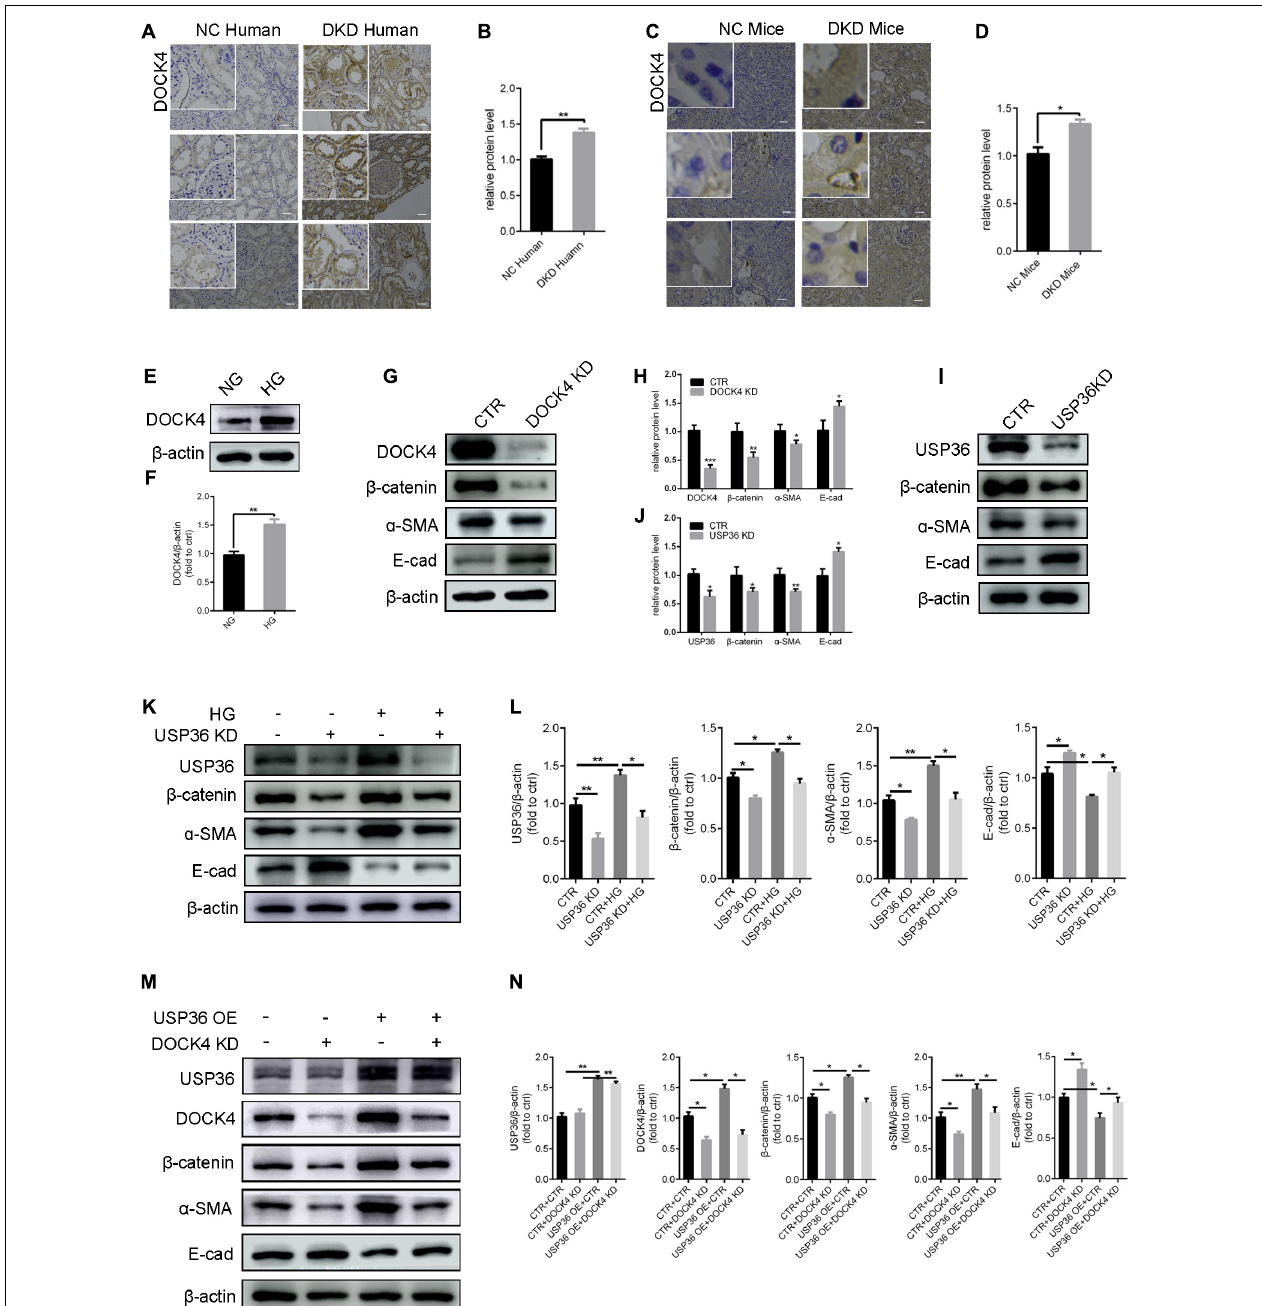
FIGURE 5 | USP36 regulates EMT induced by high glucose of TECs via DOCK4-dependent Wnt/ β -catenin signaling pathway. (A,B) Immunohistochemistry staining for DOCK4 expression in human kidney sections. Scale bars = 100 µ m, n = 3. (C,D) Immunohistochemistry staining for USP36 expression in mouse renal tissues. Scale bars = 100 µ m, n = 3. (E,F) WB analysis of the protein levels of DOCK4 in high glucose induced TECs. Data are presented as the mean ± S.D, n = 3, * p < 0.05. (G,H) WB analysis of the protein levels of DOCK4, β -catenin, α -SMA and E-cad in TECs after knockdown of DOCK4. Data are presented as the mean ± S.D, n = 3. * p < 0.05, ** p < 0.01, and *** p < 0.001. (I,J) WB analysis of the protein levels of USP36, β -catenin, α -SMA and E-cad in TECs after knockdown of USP36. Data are presented as the mean ± S.D, n = 3, * p < 0.05, and ** p < 0.01. (K,L) WB analysis of the protein levels of USP36, β -catenin, α -SMA and E-cad in TECs exposed to long time high glucose following the knockdown of USP36. Data are presented as the mean ± S.D, n = 3, * p < 0.05, and ** p < 0.01. (M,N) WB analysis of the protein levels of USP36, DOCK4, β -catenin, α -SMA, and E-cad after co-transfected with USP36-overexpressing and DOCK4-silencing siRNA. Data are presented as the mean ± S.D, n = 3, * p < 0.05, and ** p < 0.01.